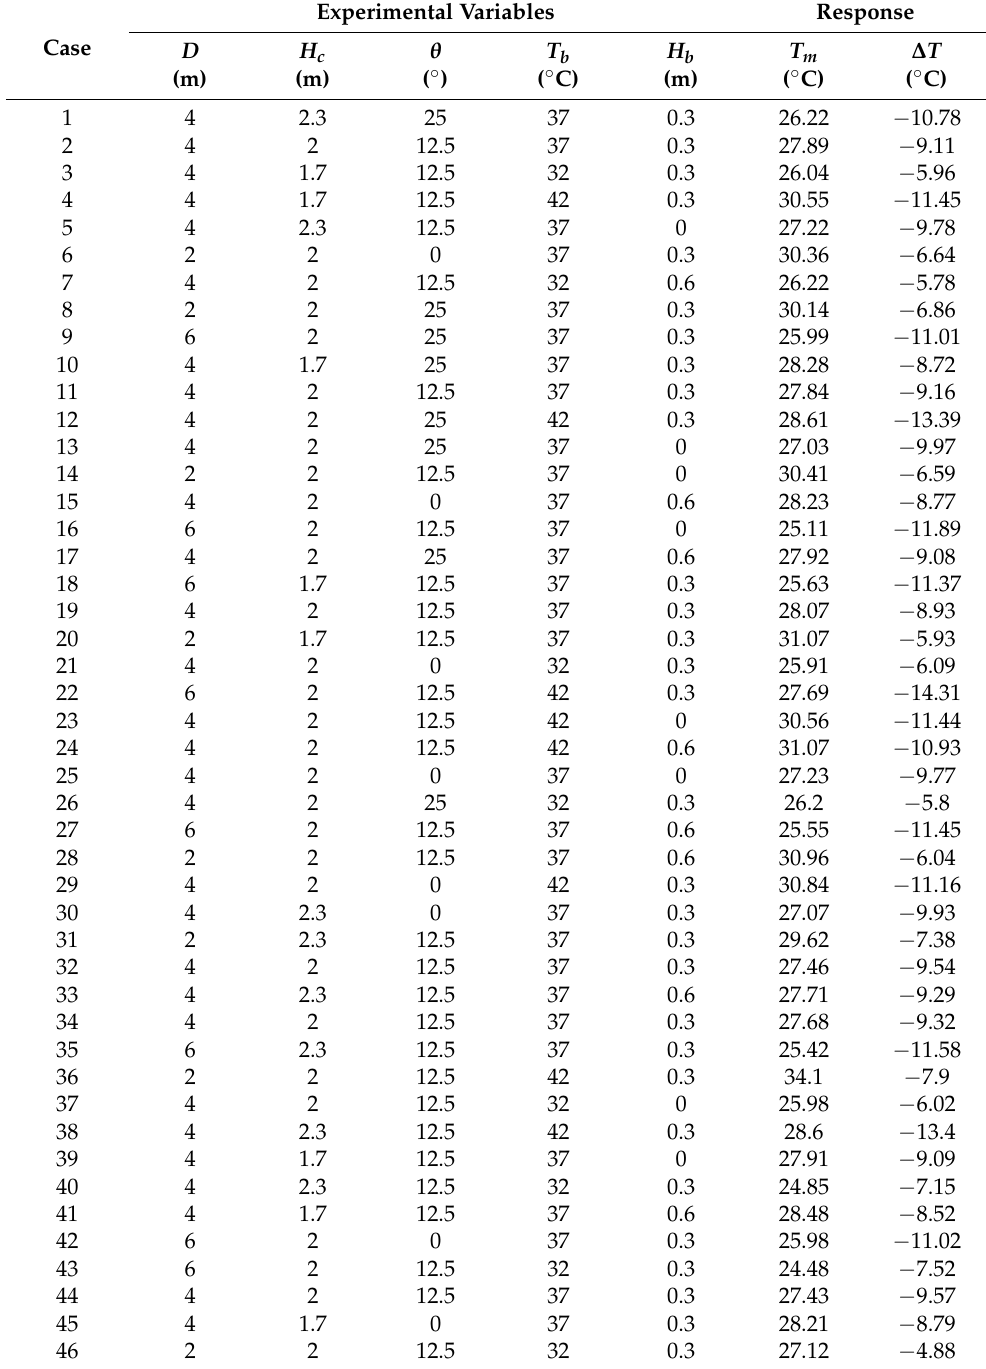
Table 2. BBD with the values of each variable and the corresponding values of the response (served as the training dataset). D , H c , θ , T b , and H b represent the horizontal distance, the camera height, the angle of view between the camera and black body cavity, the black body cavity temperature, and the black body cavity height,